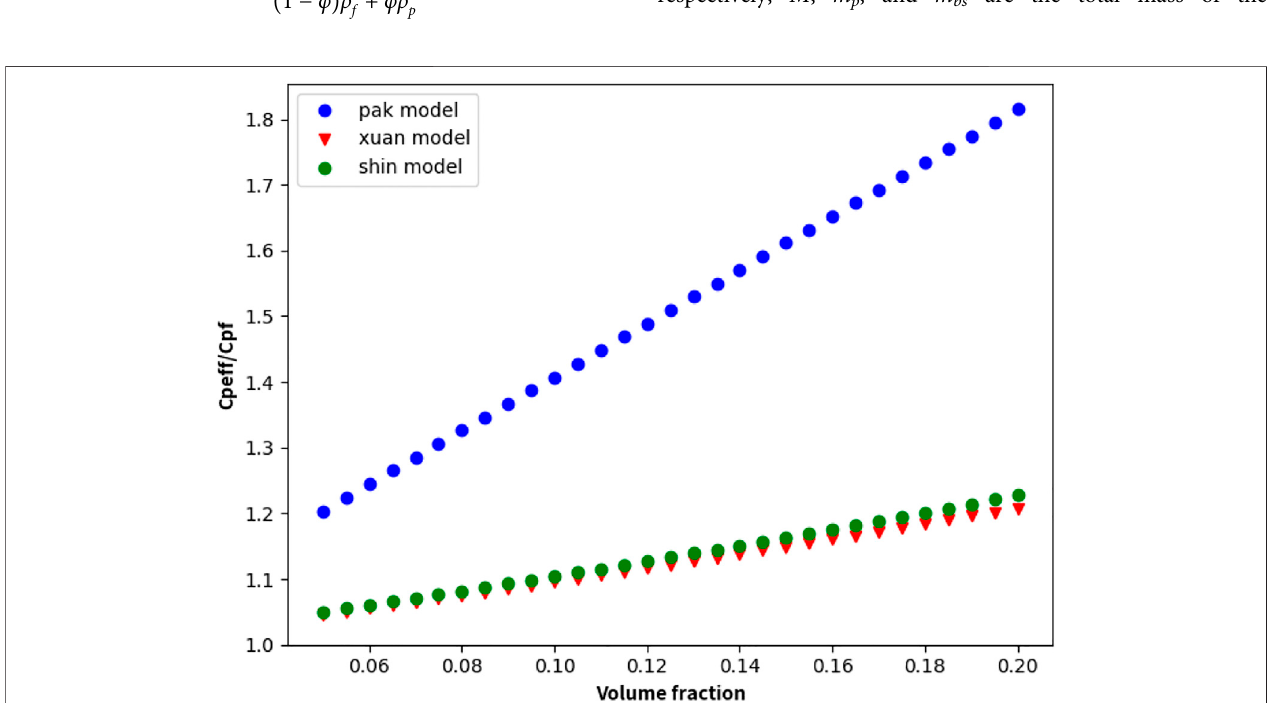
FIGURE 9 | Variation in the speci fi c heat capacity of lead – bismuth-based graphene nano fl uid with nanoparticle concentration.